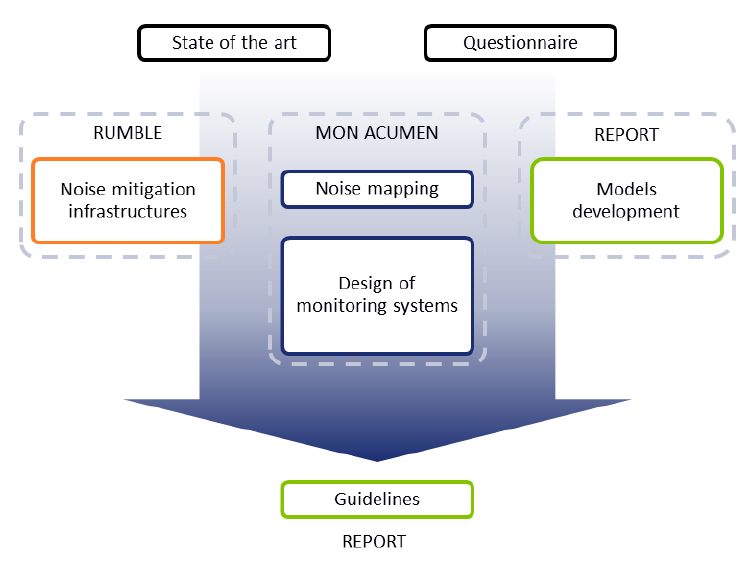
Figure 3. Structure of the Interreg projects activities.